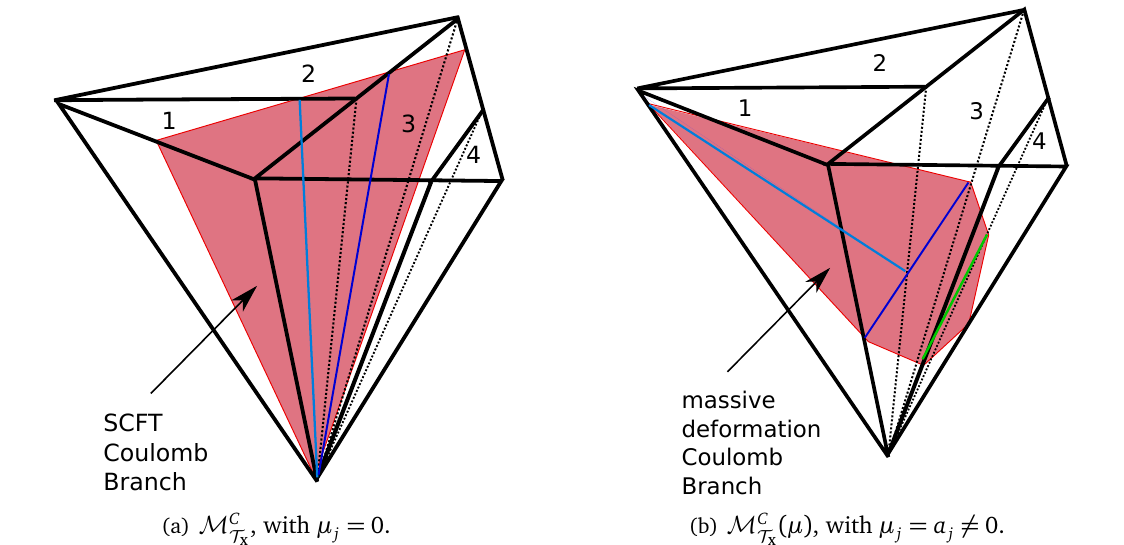
Figure 1: Structure of the extended Coulomb parameter space of a 5d SCFT. On the left-hand-side, we represent the codimension- f hypersurface µ which corresponds to the Coulomb branch, M C slicing of the parameter space with µ corresponds to the Coulomb branch of a theory obtained from the 5d SCFT by a mass